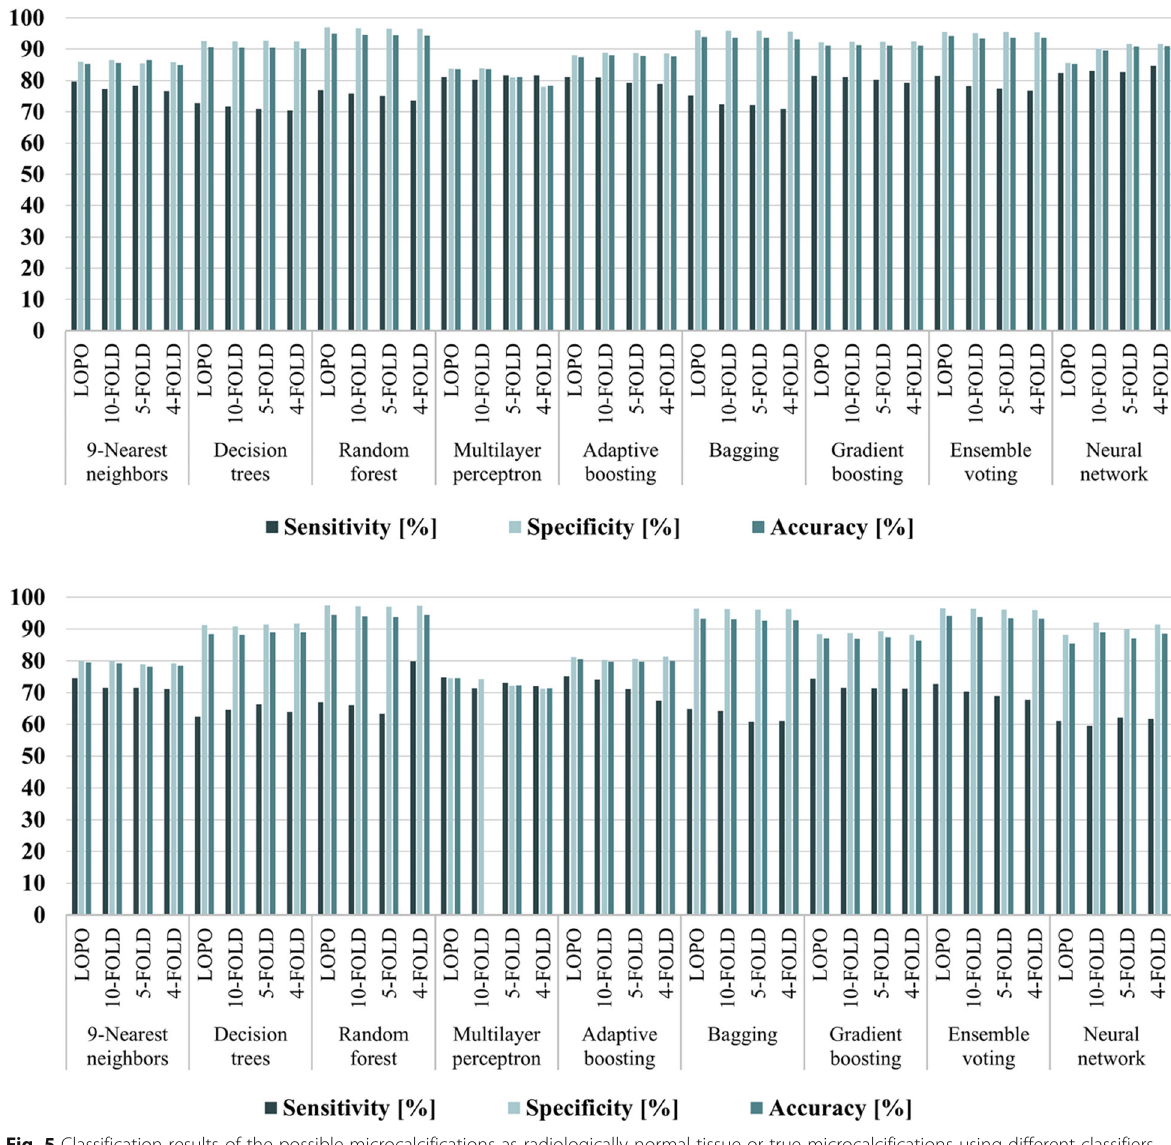
Fig. 5 Classification results of the possible microcalcifications as radiologically normal tissue or true microcalcifications using different classifiers and cross-validation methods. up Results using temporal subtraction of mammograms. down Results using only the most recent mammograms. LOPO